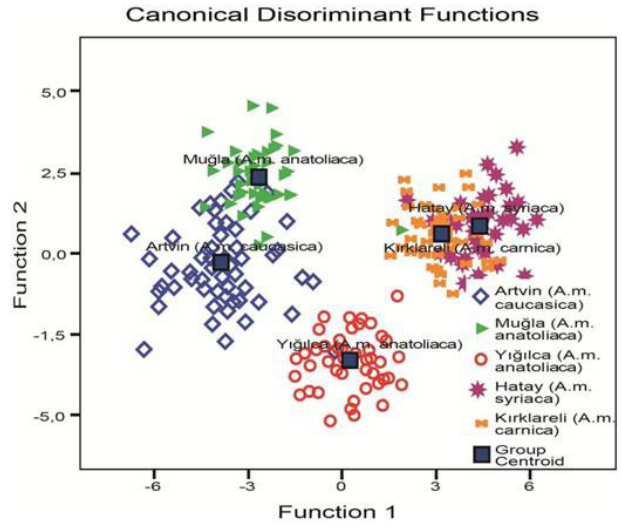
Fig 3. The discrimination of native honeybee race and ecotypes from isolated area on two dimensional scatter plot by using geometric